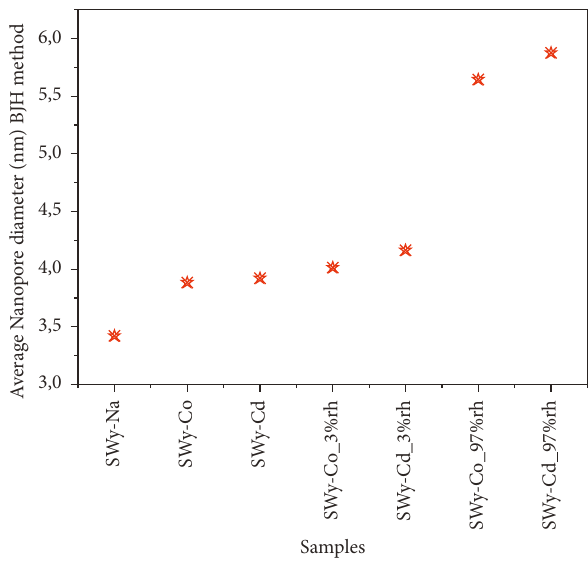
Figure 7: BJH method average pore diameter for unstressed and stressed